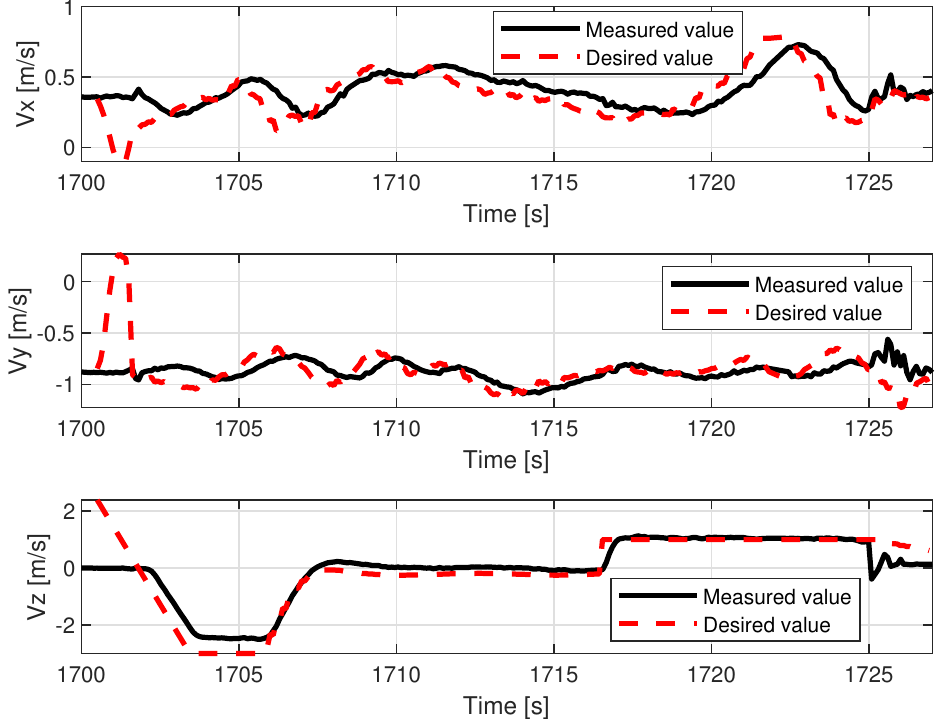
Figure 20. Multicopter linear speeds during the in-flight